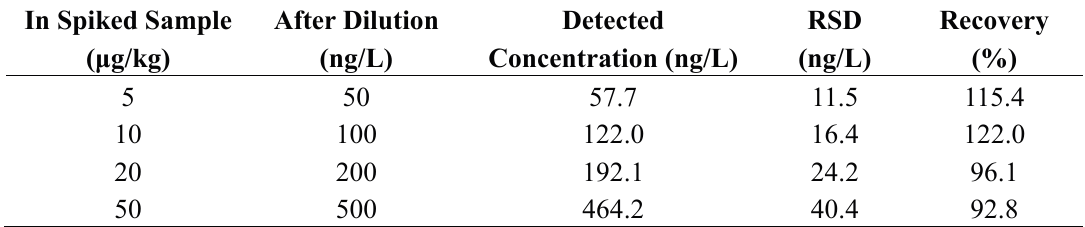
Table 2. The detected results of AFB in maiz samples and recoveries ( n =